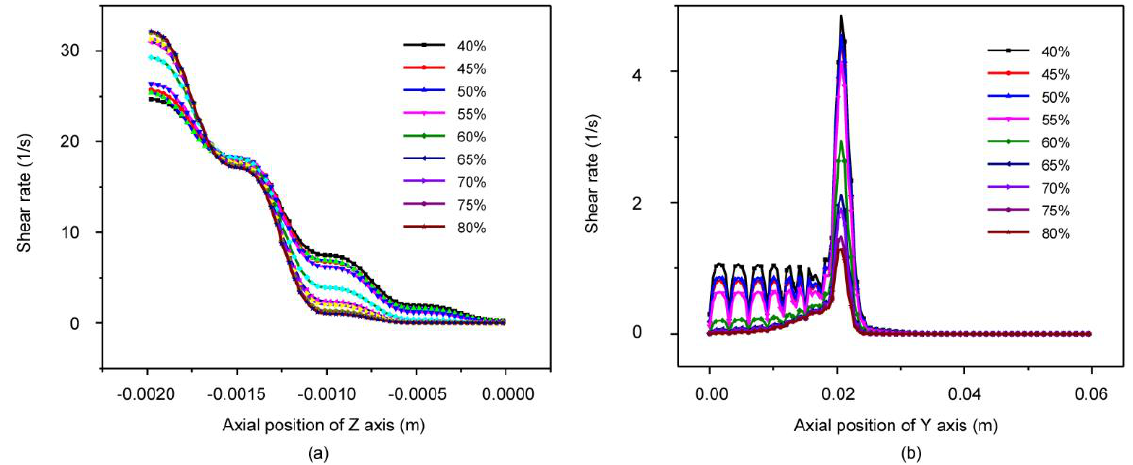
Figure 10. Shear rate distribution on the centerline along the ( a ) z-axis and ( b ) y -axis.